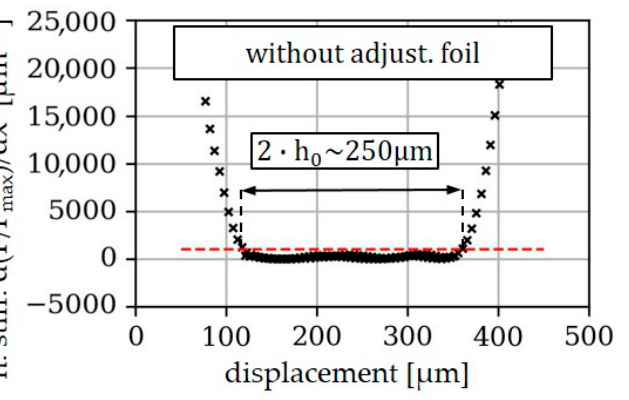
Figure 4. Example of a stiffness curve for the bearing configuration without adjustment foil at 60°–240°; position-dependent normalized stiffness (black crosses); and threshold level (red dashed line).